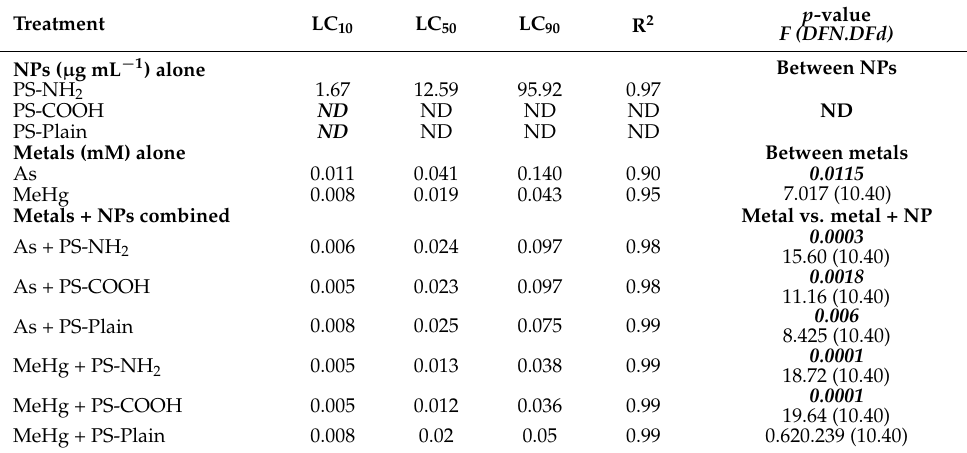
Table 1. Values of LC 10 , LC 50 , LC 90 and R 2 calculated after exposure of SaB-1 cells for 24 h to functionalized polystyrene nanoplastics (PS-NH 2 , PS-COOH and PS-Plain) or metals (As and MeHg) alone or metals in combination with 1 µ g mL − 1 of functionalized polystyrene nanoplastics (PS-NH 2 , PS-COOH and PS-Plain) ( n = 3). LCs were calculated through interpolation of a nonlinear regression with a four-parameter dose-response curve. Student’s t test was applied to compare two fitted curves. p -value was established at 0.05. LC, lethal concentration; PS, polystyrene; NP, polystyrene nanoplastics; As, arsenic; MeHg, methylmercury; ND, not detected. Treatment LC 10 LC 50 LC 90 R 2 p- value F (DFN.DFd) NPs ( µ g mL − 1 )